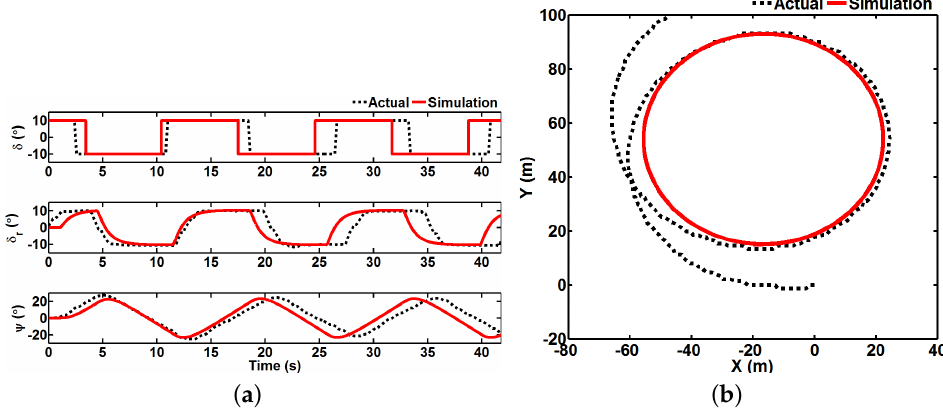
Figure 4. The comparison results of two tests. ( a ) 10 ◦ /10 ◦ zig-zag test; ( b ) 10 ◦ turning